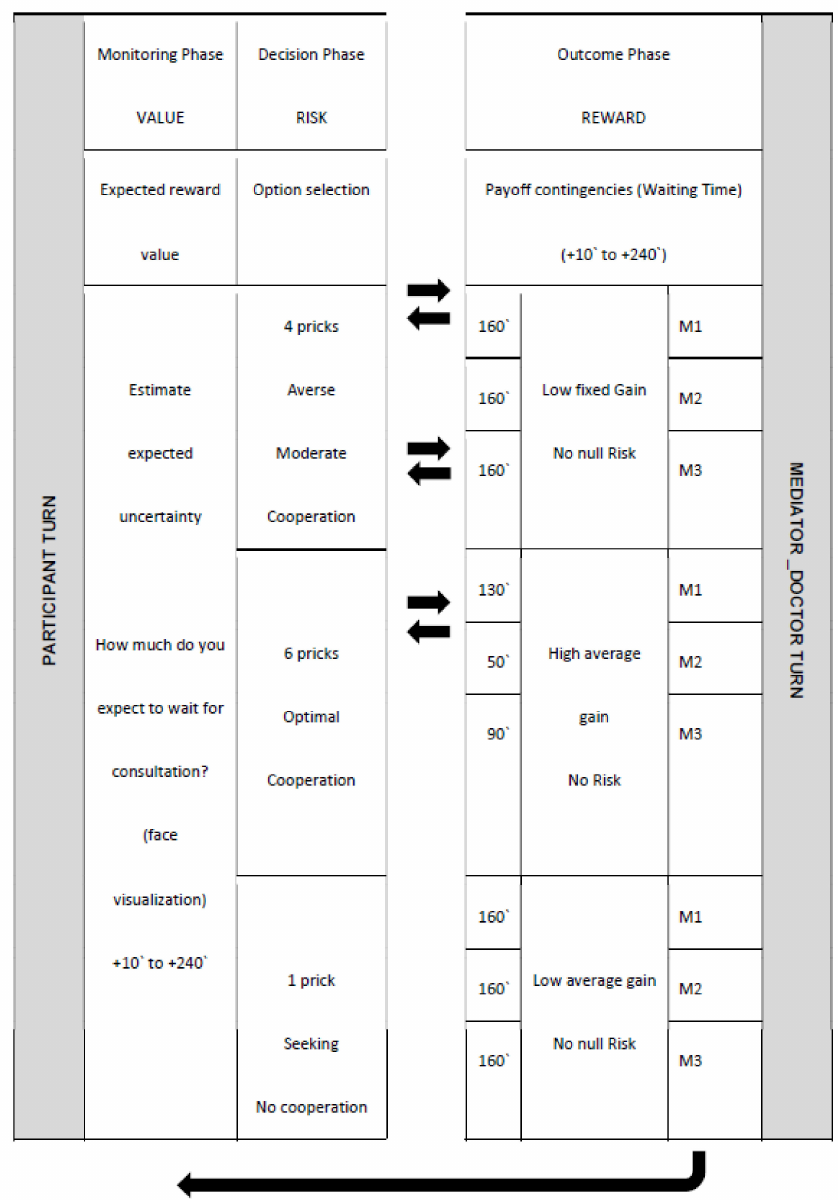
Figure 2. Example of health experimental design considering a run sequence in doctor-patient interaction. For details see